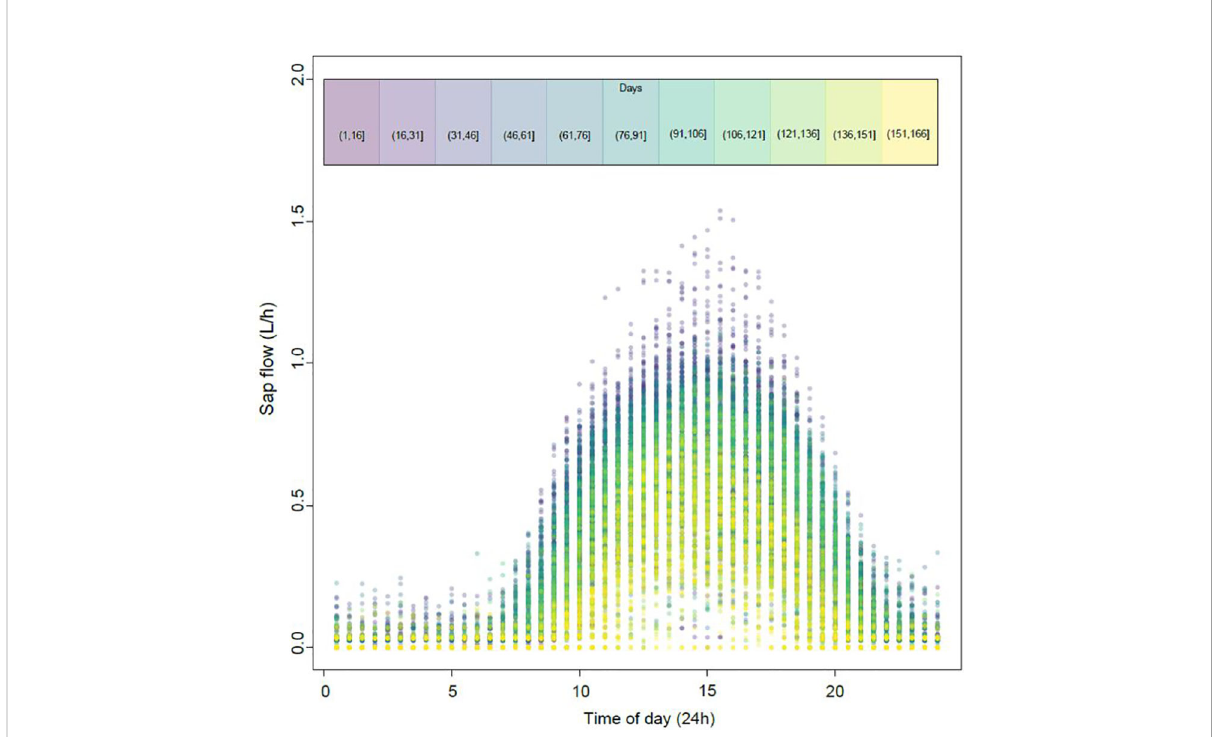
FIGURE 1 Pooled observations of daily sap fl ow data recorded every 30-minutes at four different locations under a Voen protected cropping system. Day 1 was October 17 th 2020. Dot colour represents the different time periods throughout the season as highlighted in the colour chart at the top of the fi gure (eg. Purple represents days 1-16, yellow represents days